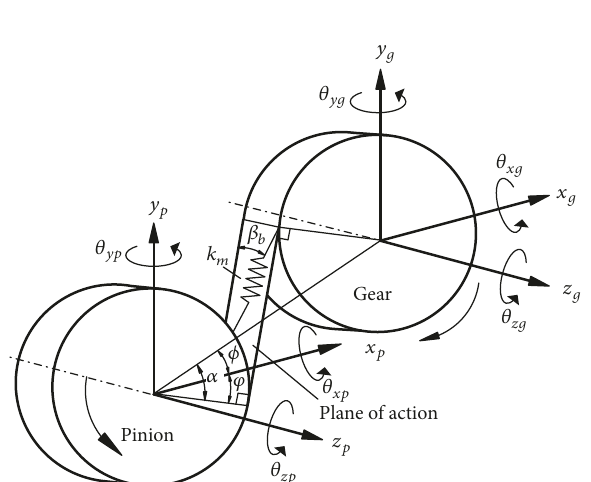
Figure 3: Dynamic model of gear